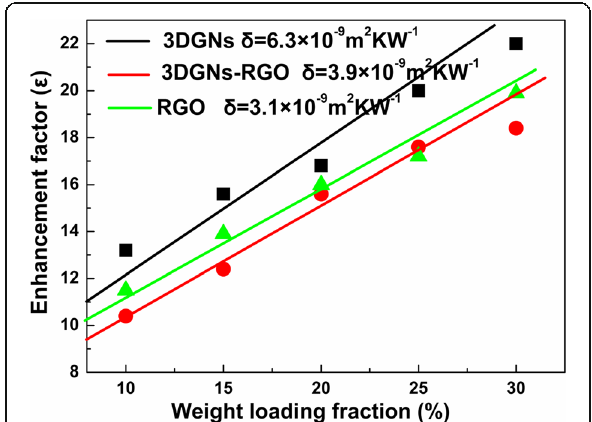
Fig. 4 Calculated thermal boundary resistance of the various samples. Thermal boundary resistance ( δ ) is an important parameter to determine the resulting thermal performances of TIMs. Based on Balandin ’ s theory, thermal conductivity of graphene-modified ER is closely related to the value of the δ . After calculation, the similar δ values of the RGO-ER and RGO-3DGNs-ER samples prove that the added RGO nanosheets are loaded on the surface of the 3DGNs (Fig. 4). Based on our previous findings, the δ value of the 3DGNs-ER sample is much higher that of the RGO-ER because of the poor contact between the 3DGNs and ER. The functional groups of the RGO nanosheets bring about a better contact at the interface, which leads to the smaller δ compared with that of 3DGNs-ER